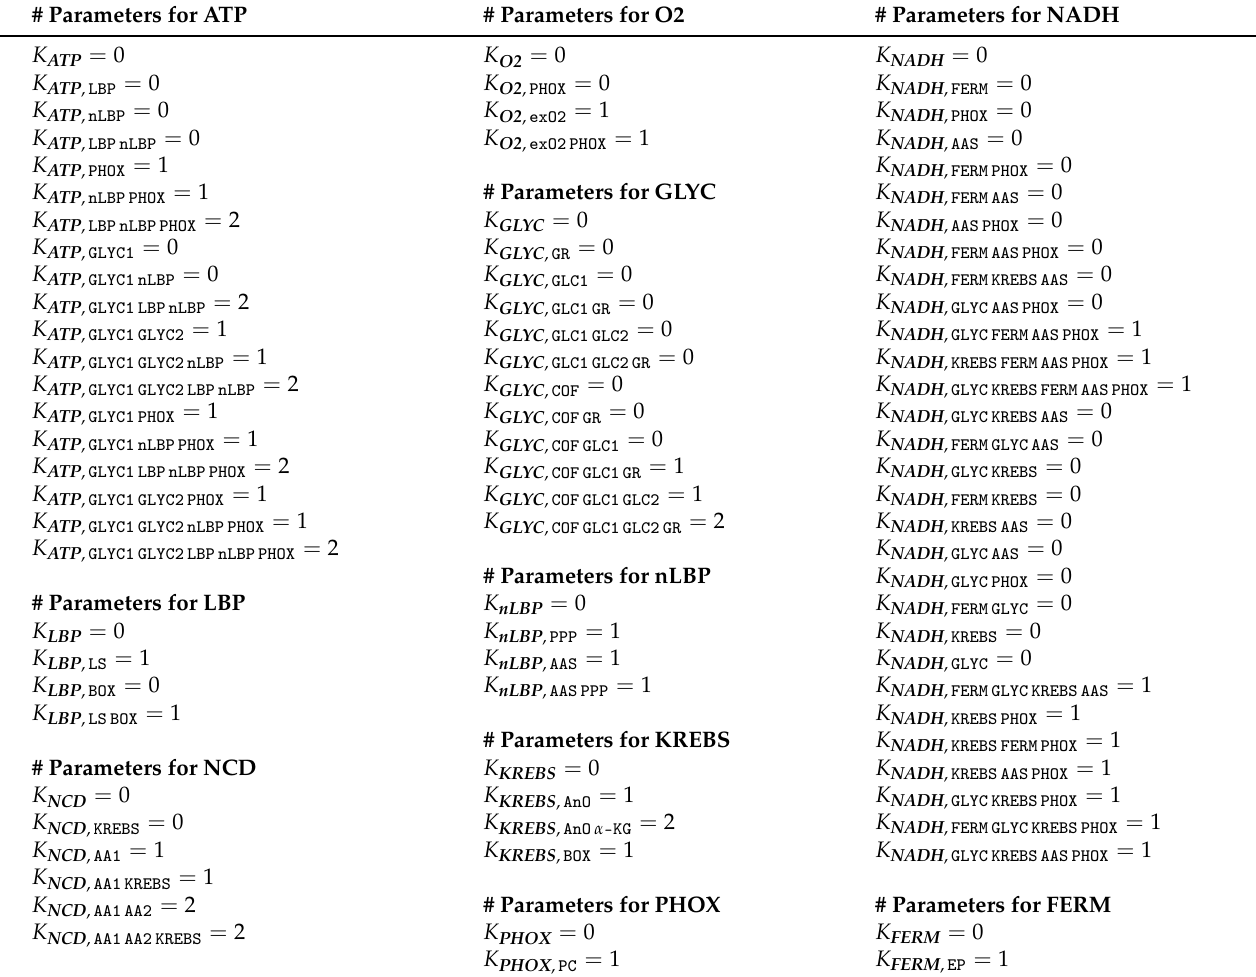
Table 1. Kinetic parameter values from Section 5.2. Only 7 parameter values remain free: K ATP , LBPPHOX , K ATP , GLYC1LBP , K ATP , GLYC1GLYC2LBP , K ATP , GLYC1LBPPHOX , K ATP , GLYC1GLYC2LBPPHOX , K NADH , FERMGLYCPHOX and K NADH , FERMGLYCKREBS .